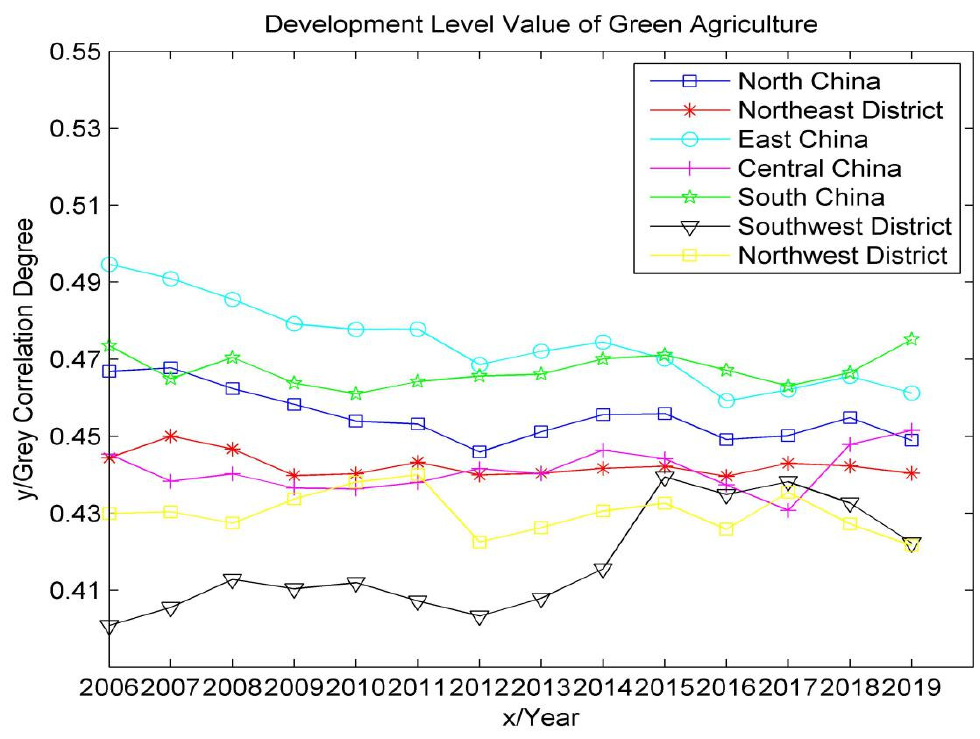
Figure 4. Time series trend of development level of green agriculture.